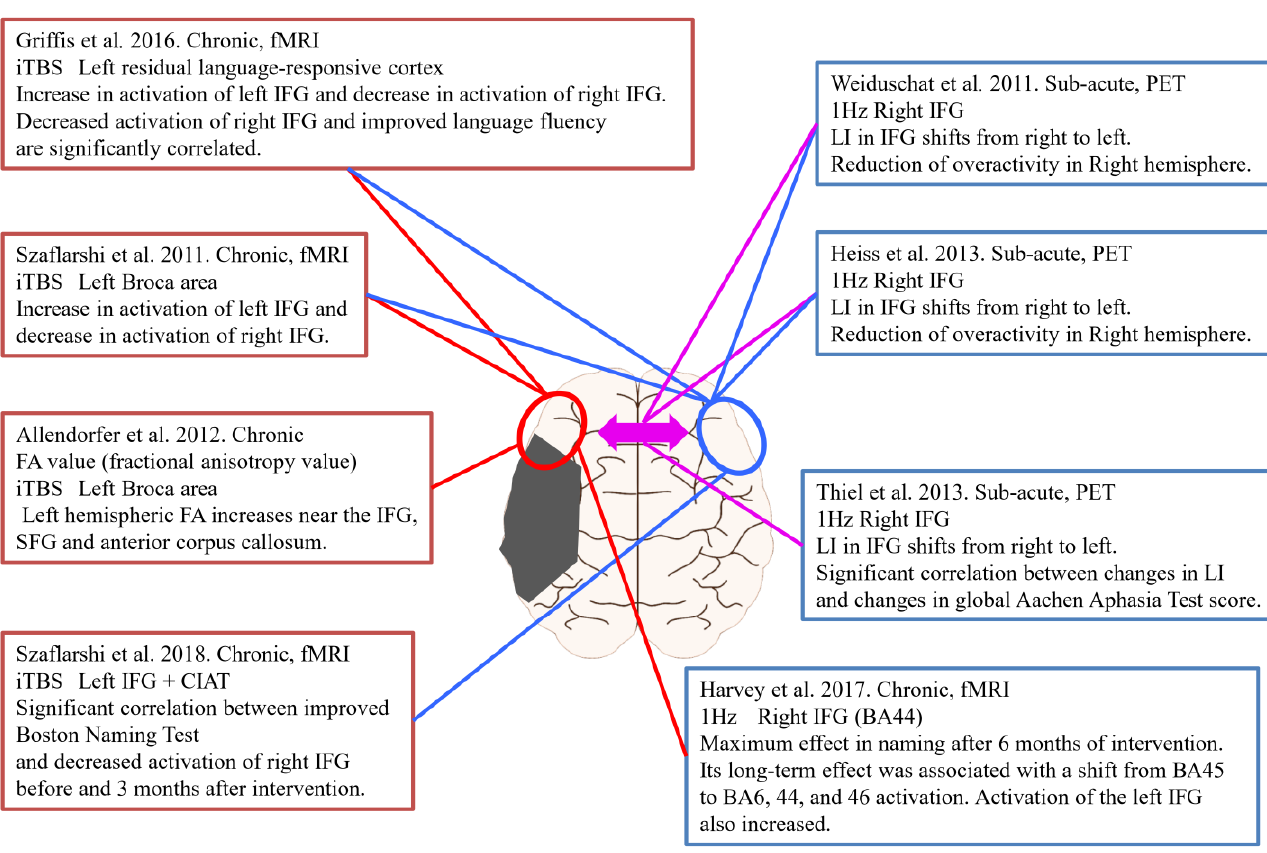
Figure 4. rTMS intervention and Neuroimaging assessment in PSA.